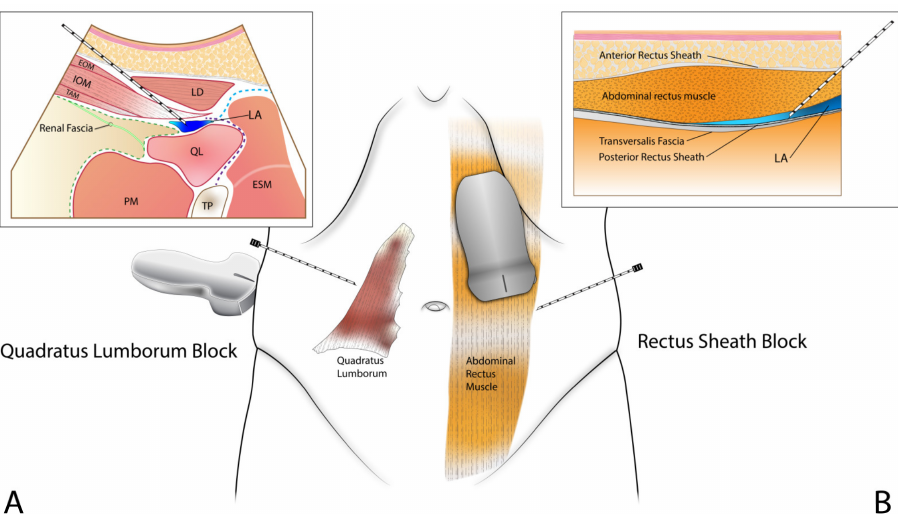
Figure 2. Abdominal wall blocks conducted in the R group. Schematic diagram. ( A ) Ultrasound guided quadratus lumborum block (type I). The target of the injection point is the fascial plane between the quadratus lumborum muscle and the transversus abdominis muscle. ( B ) Ultrasound guided rectus sheath block. The target of the injection point is the fascial plane between the posterior rectus sheath and the abdominal rectus muscle. Abbreviations are as follows: LA, local anesthetic; EOM, external oblique muscle; IOM, internal oblique muscle; LD, latissimus dorsi muscle; PM, psoas muscle; QL, quadratus lumborum muscle; TP, transverse